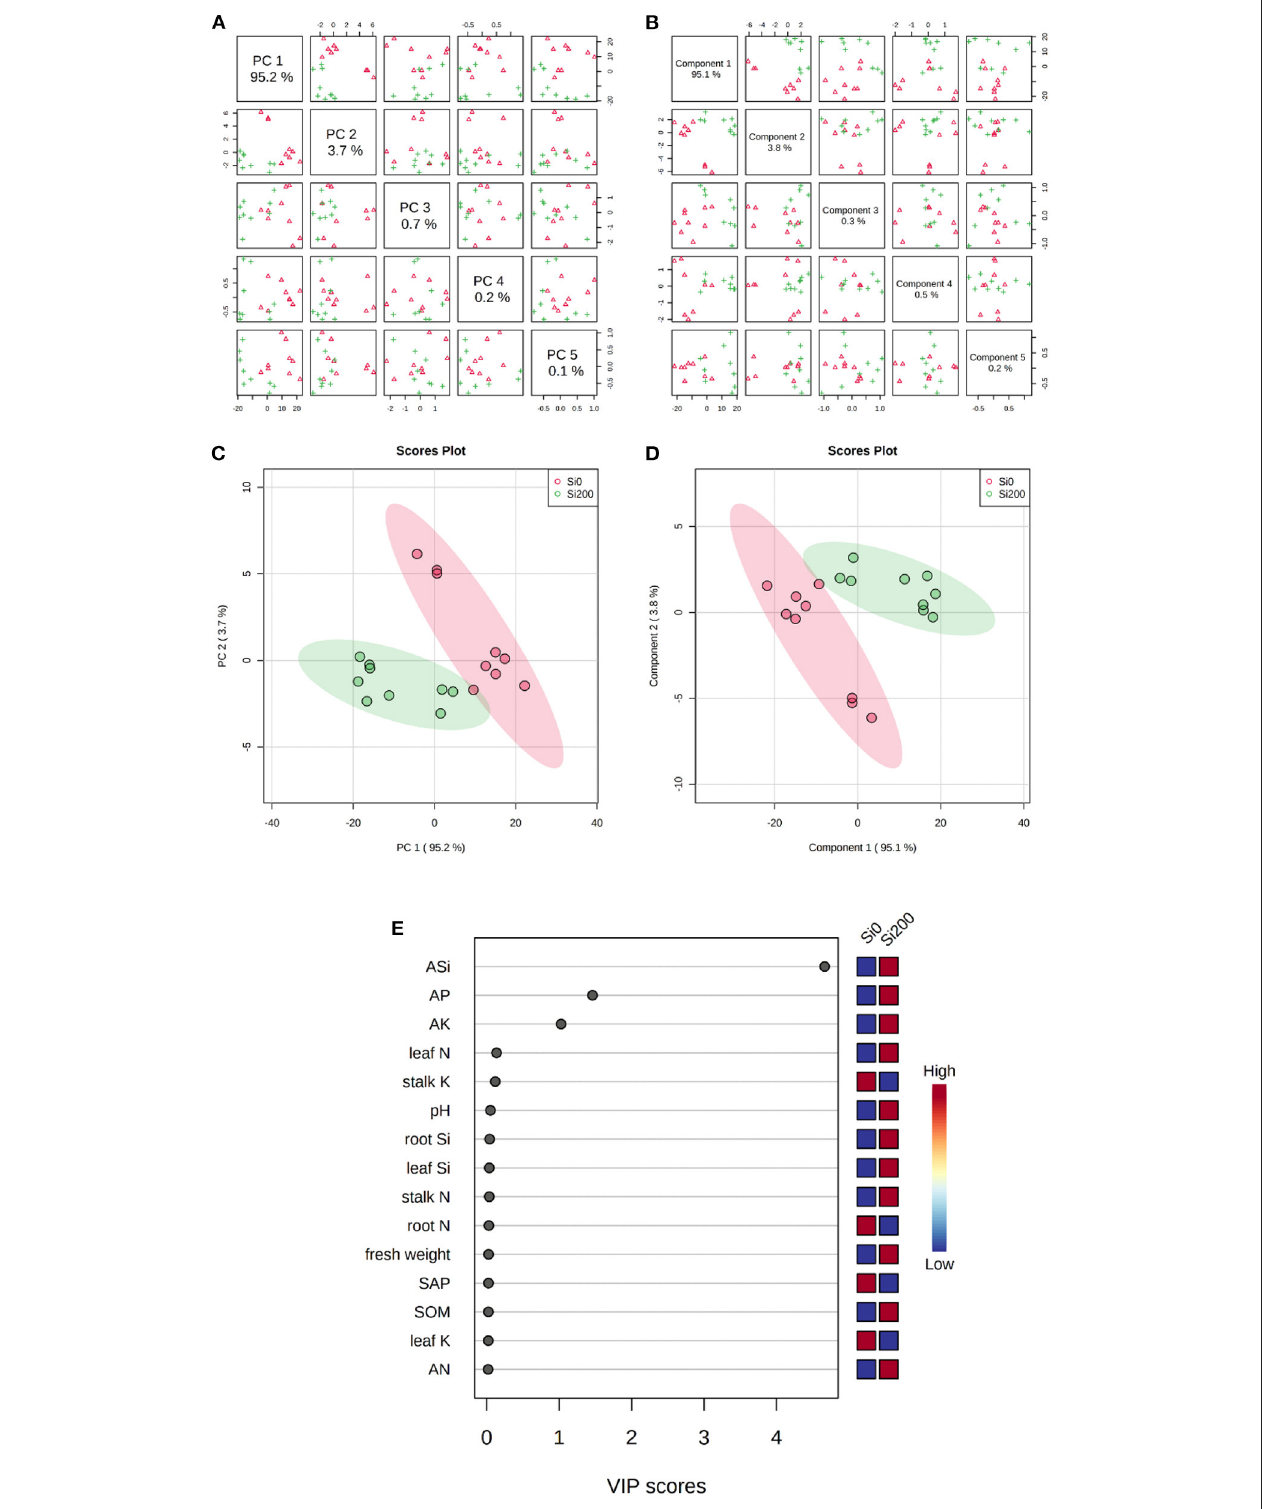
FIGURE 2 | Principal component analysis (PCA) (A,C) and partial least squares-discriminant analysis (PLS-DA) (B,D) of the investigated parameters, and the variable importance in projection (VIP) to component 1 of the PLS-DA for the two Si treatments (E) .